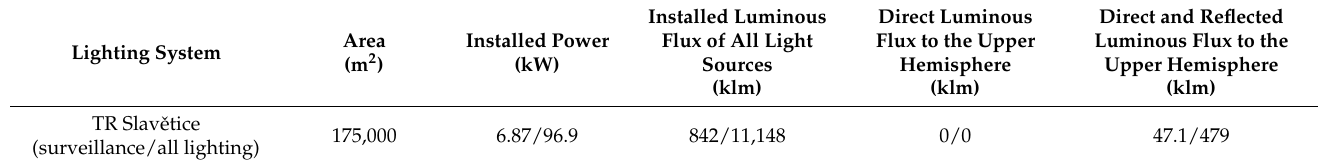
Table 11. Overview of the operational modes of TR Slavˇetice electrical